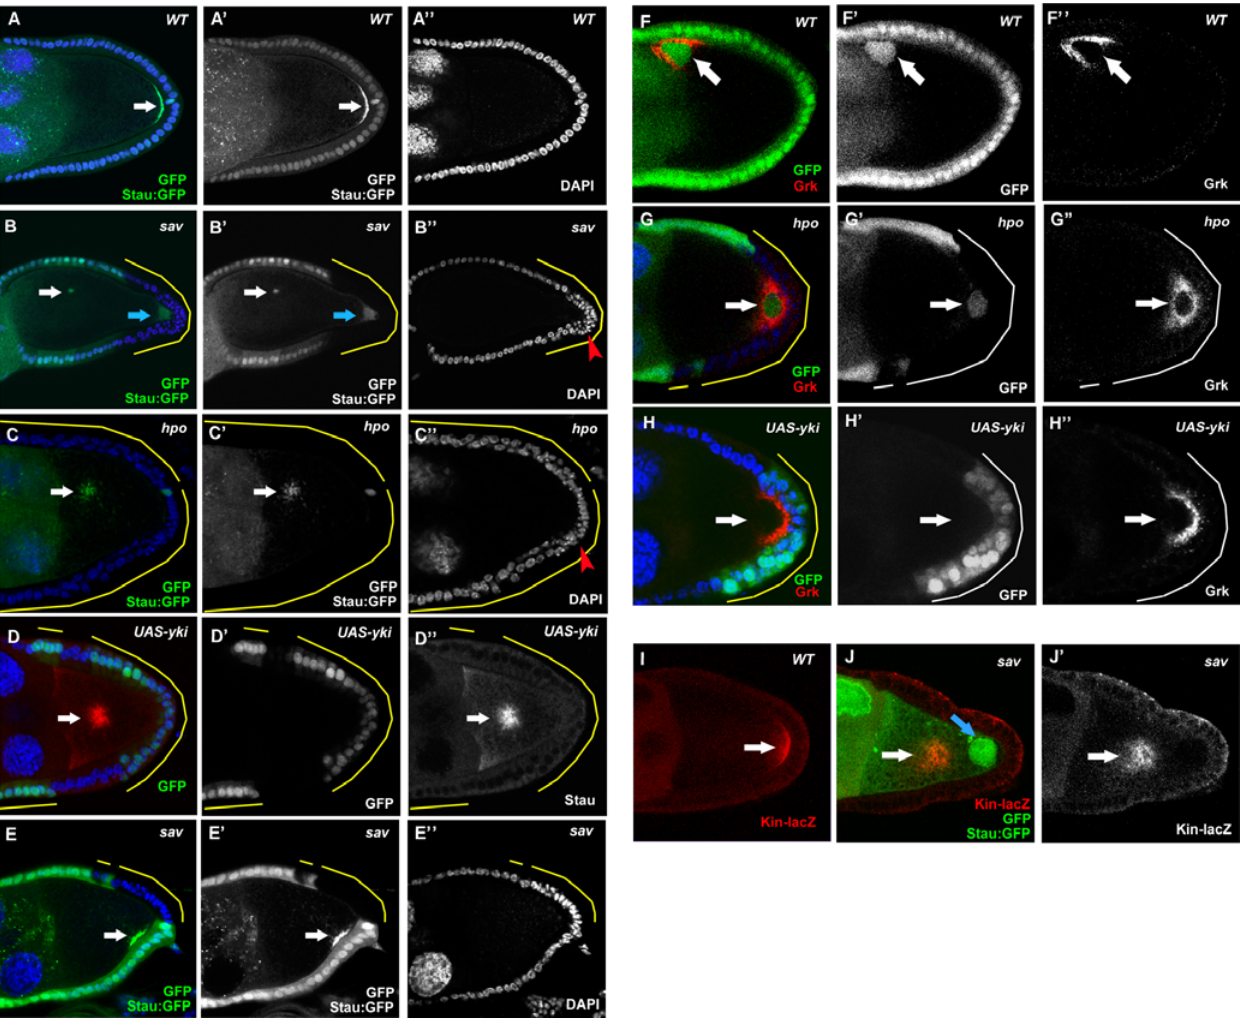
Figure 1. The Hpo pathway is required for oocyte polarity formation. (A) Stau:GFP (arrow) is localized to the posterior of wild-type stage-9 oocytes. (B) Large sav follicle-cell clones cause a complete mislocalization of Stau-GFP (white arrow) toward the oocyte center, and the oocyte nucleus (blue arrow) remains at the posterior. (C) A stage 9 egg chamber with large hpo PFC clone also shows mislocalization of Stau:GFP toward the center of the oocyte (arrow). (E) Stau (arrow) is mislocalized away from the region adjacent to the sav clones when the PFC are partially mutated. (F) Oocyte nucleus and Grk (arrow) are localized to the dorsal anterior corner of wild-type stage-9 oocytes. (G) Large hpo follicle-cell clones cause mislocalization of the oocyte nucleus and Grk (arrow) at the oocyte posterior. Overexpression of Yki also caused Stau (D, arrow) and Grk (H, arrow) mislocalization. (I) Plus ends of microtubules, visualized with Kin: b -Gal (arrow) localization at the posterior of a wild-type stage-9 oocyte. (J) A stage-9 egg chamber with a large sav follicle-cell clone showing abnormal Kin: b -Gal (arrowhead) localization in the center of the oocyte, as well as mislocalization of the oocyte nucleus (blue arrow). Multilayering and small nuclear phenotypes can be observed in PFC clones of both sav and hpo mutants (red arrowheads). Loss-of-function clones are marked as the GFP-negative cells. Gain-of-function clones ( UAS-Yki ) are GFP-positive. All clones are additionally highlighted by yellow lines to indicate the affected follicle cells, except in a few cases of complete or almost complete follicle cell clones. In all Figures, posterior is to the right. Nuclei are marked in most figures by DAPI staining in